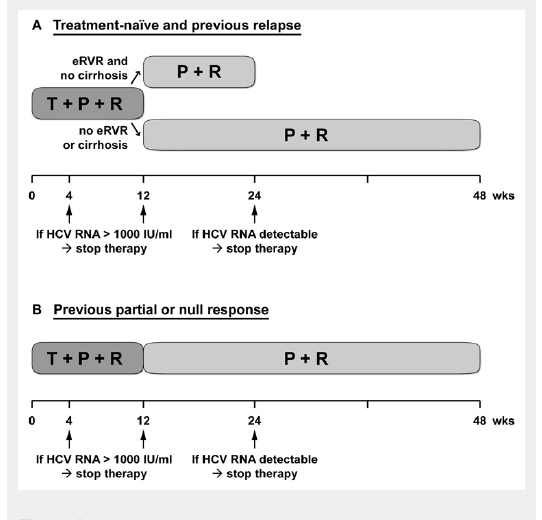
Boceprevir-based triple therapy. (A) Treatment-naïve patients with CHC of genotype 1 without cirrhosis. (B) Treatment-experienced patients with CHC genotype 1 and previous relapse or partial response without cirrhosis. (C) All cirrhotic patients and prior null responders. B, boceprevir; BPR = B + P + R; P, pegylated interferon-α; R, ribavirin; RVR8, rapid virological response at